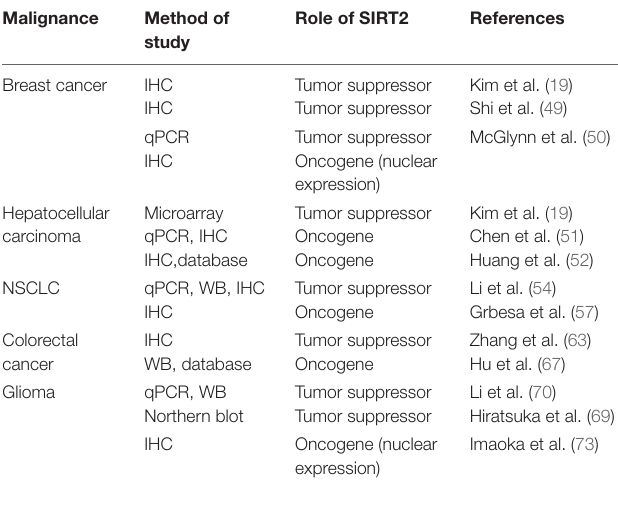
TABLE 2 | The clinical role of SIRT2 in five